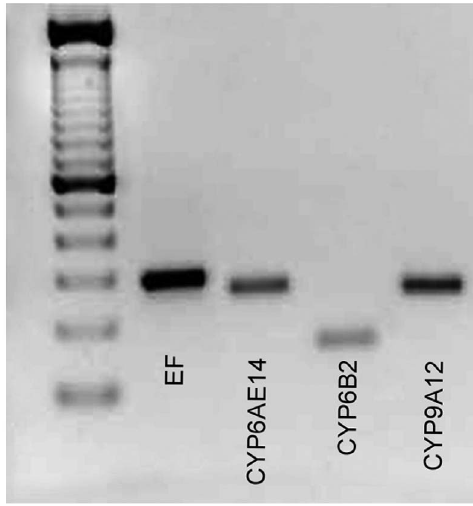
Figure 4. cDNA fragments produced from midgut tissues of Helicoverpaarmigera larvae. Specific products were obtained for the elongation factor EF-1 a (279bp), CYP6AE14 (241bp), CYP6B2 (140bp), and CYP9A12 (233bp).